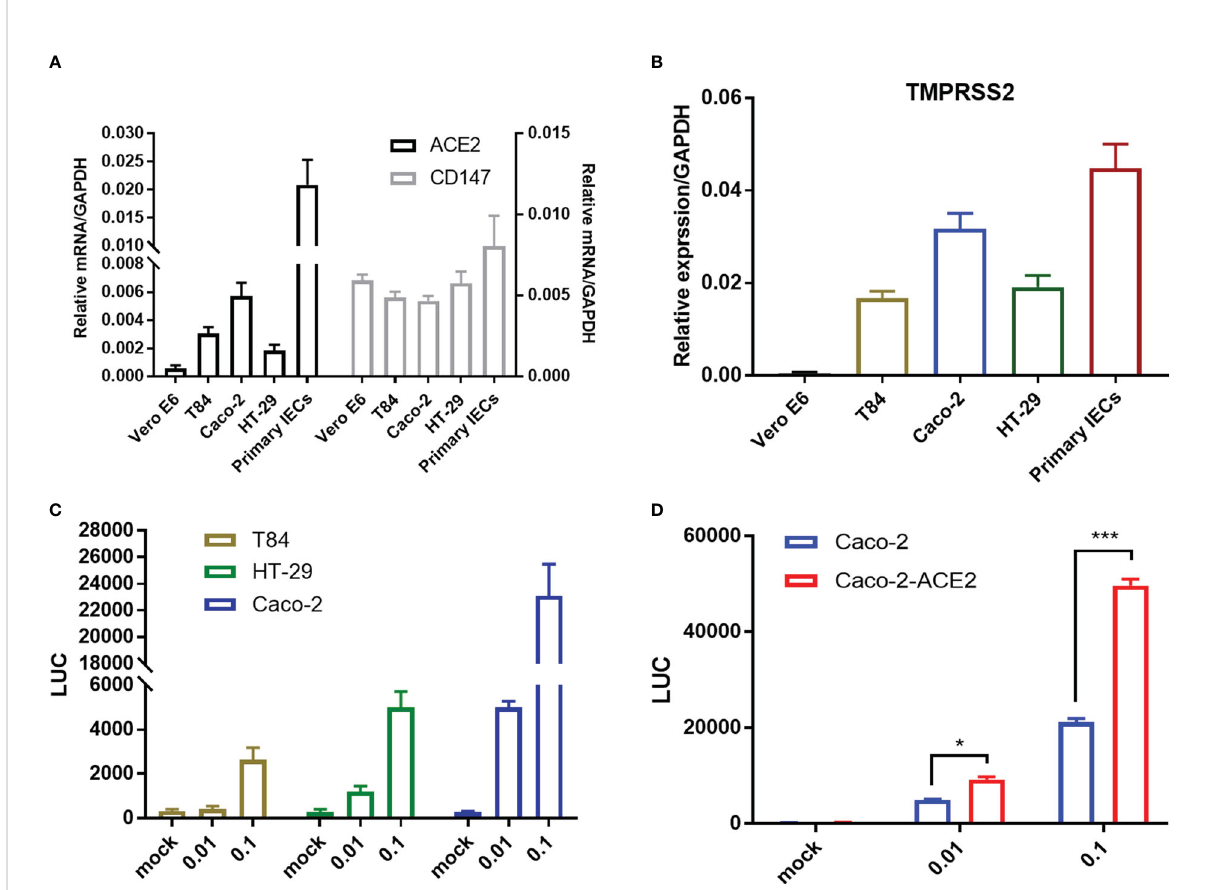
FIGURE 1 Entry receptor expression and permissiveness of intestinal epithelial cells to SARS-CoV-2 pseudo-virus. mRNA expression of SARS-CoV-2 entry receptor ACE2, CD147 (A) and coreceptor TMPRSS2 (B) on Vero E6, multiple epithelial cell lines and primary epithelial cells respectively. (C) Indicated intestinal epithelial cell lines (1x10 5 ) were infected with VSV-SARS-CoV-2 pseudo-virus at increasing MOIs (0.01, 0.1). Luciferase activity was determined at 24 hpi. (D) Luciferase activity in ACE2 overexpressed Caco-2 cells (Caco-2-ACE2) at 24 hpi of VSV-SARS-CoV-2 pseudo-virus with increasing MOIs (0.01, 0.1). Data are represented as mean ± SEM. Statistical signi fi cance is indicated (*p<0.05, ***p<0.001, one-way